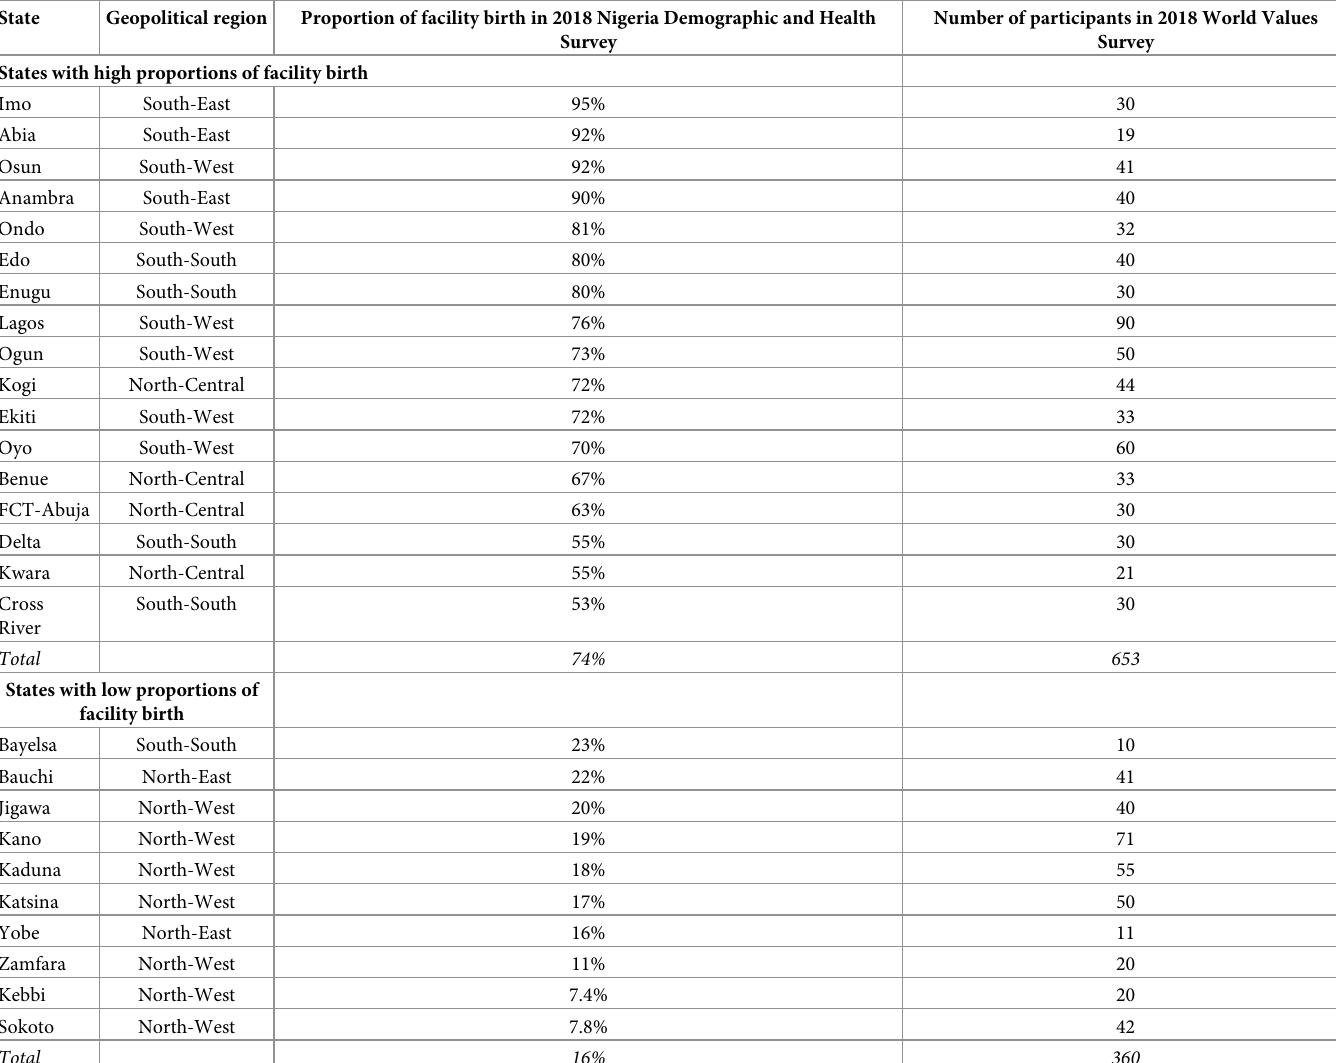
Table 1. Proportion of institutional deliveries in states with high vs. low proportions of facility birth in